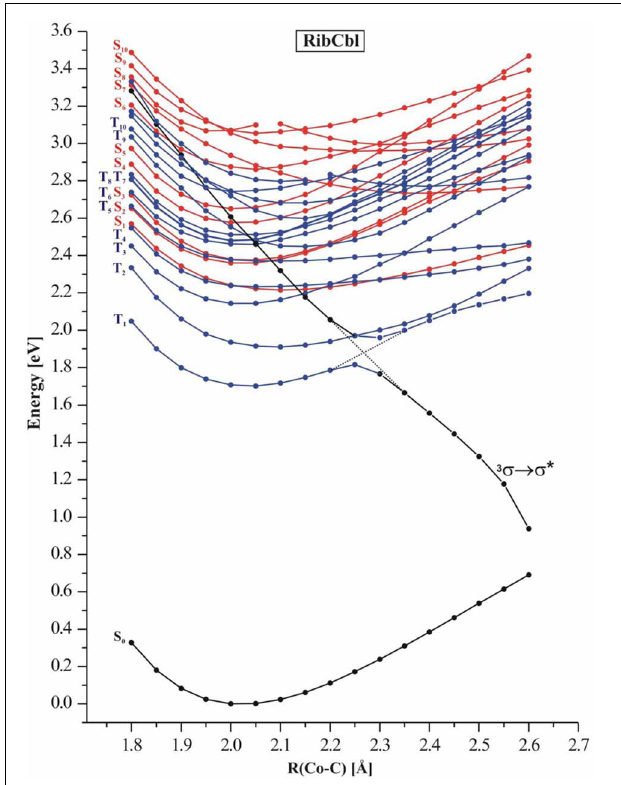
FIGURE 4 | Potential energy curves of the lowest-excited singlet (red) and triplet (blue) states of the RibCbl model complex along the Co-C bond stretch computed at TD-DFT/BP86/TZVP. The triplet repulsive state is denoted as 3 σ → σ ∗